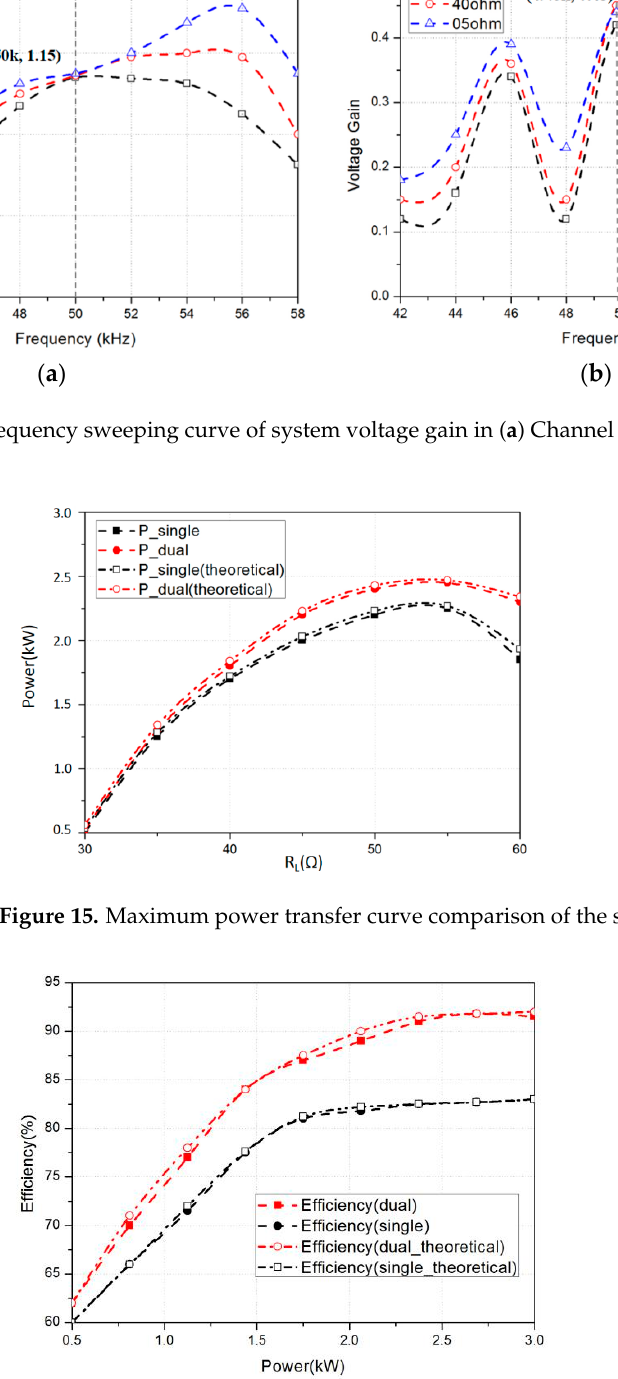
( b ) Figure 13. Key waveform of the dual-channel UWPT (under water wireless power transfer) system: ( a ) inverter output voltage and current; ( b ) current in primary and secondary coils.